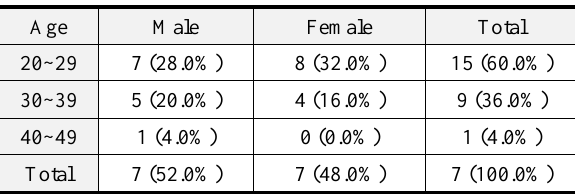
Table 1. IVR experiment participant characteristics